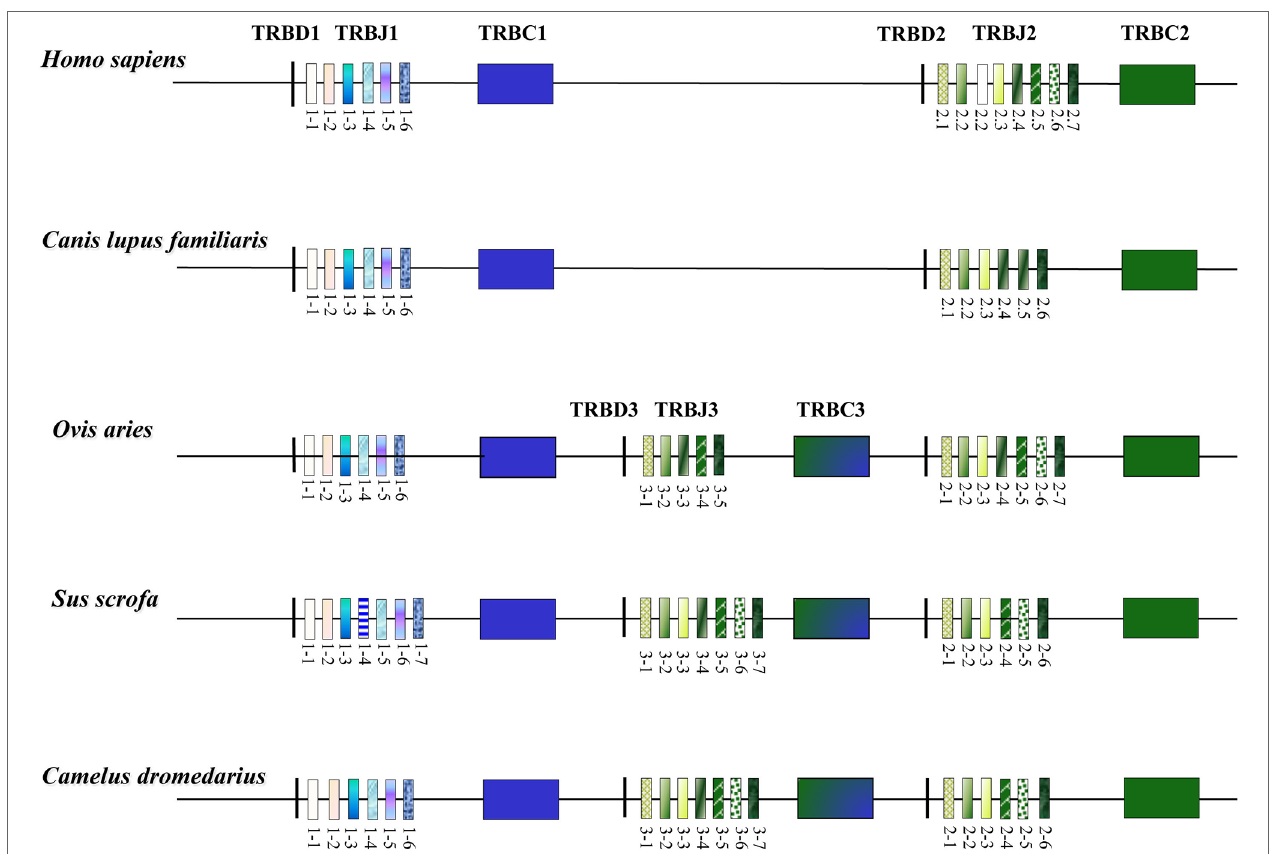
FIGURE 3 | Schematic representation of the D-J-C clusters within the TRB locus of the different mammalian species modified from Antonacci et al., 2017a. The orthologous and paralogous TRBJ genes are depicted with the same colour as deduced by the phylogenetic analysis. The double colour TRBC3 gene indicates the homologies with the TRBC1 and TRBC2 genes as result of the unequal crossover that generated the new TRB D-J-C cluster in the artiodactyl species (Antonacci et al., 2008; Eguchi-Ogawa et al., 2009).